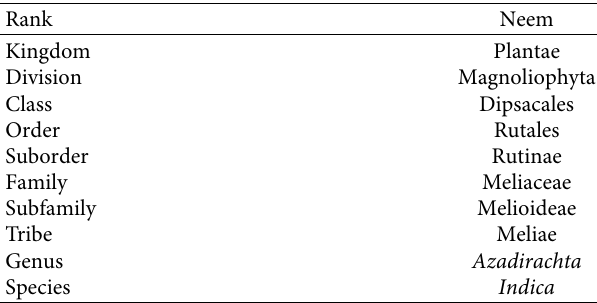
Figure 2: Flowchart for the review methodology. Table 1: Taxonomical classifcation of neem [13, 14].